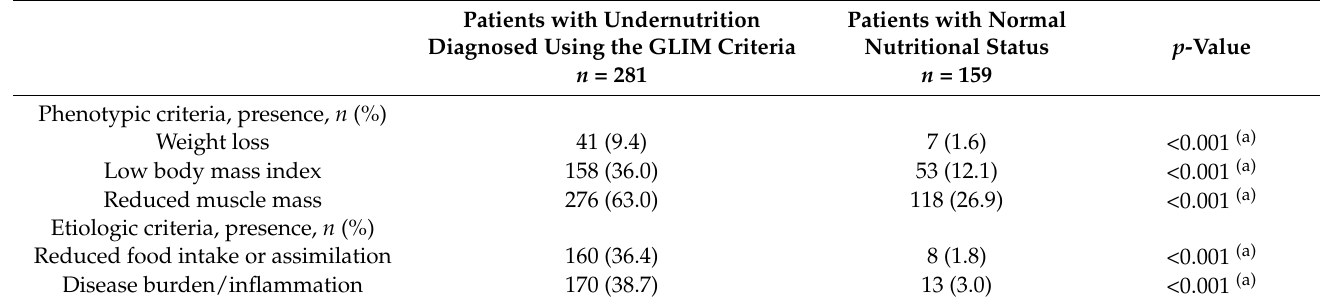
Table 2. Global Leadership Initiative on Malnutrition criteria.